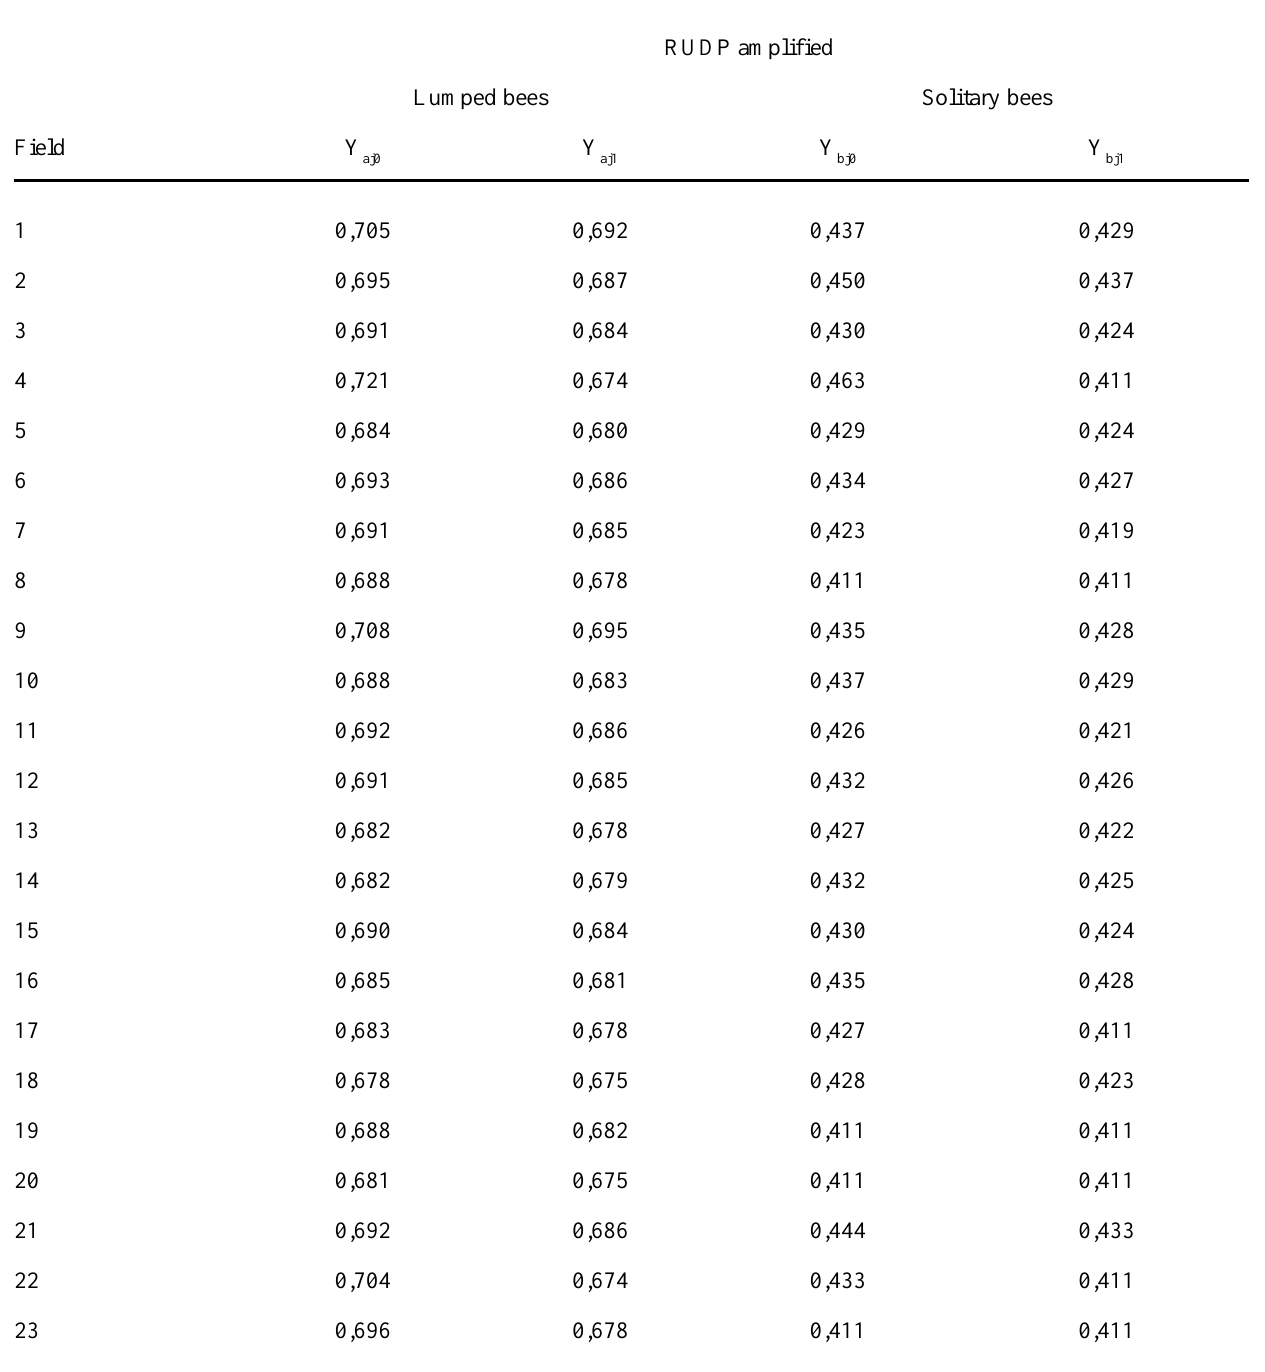
Table 3 . Number of bees per square meter before (t=0) and after (t=1) the implementation of the amplified Regional Urban Development Plan (RUDP) under the non-pollinated crop